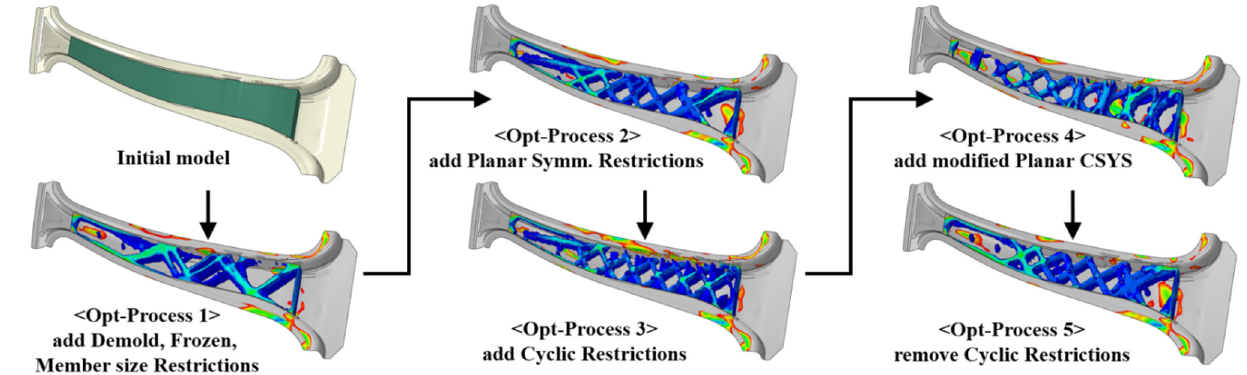
Figure 10. Topology optimization process for GFRP structure according to the change of constraint combinations.